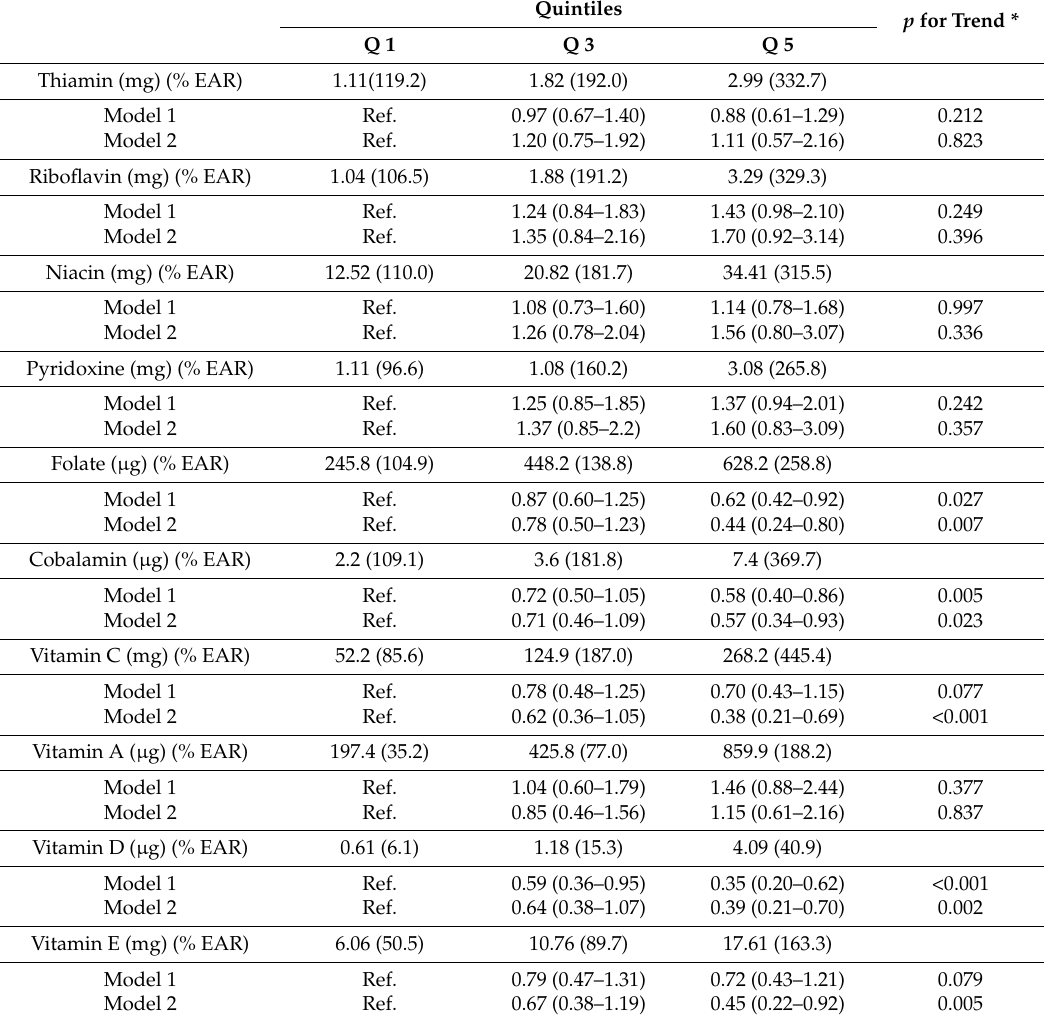
Table 2. Odds ratio (95% confidence interval) for incident chronic kidney disease according to quintiles of vitamin